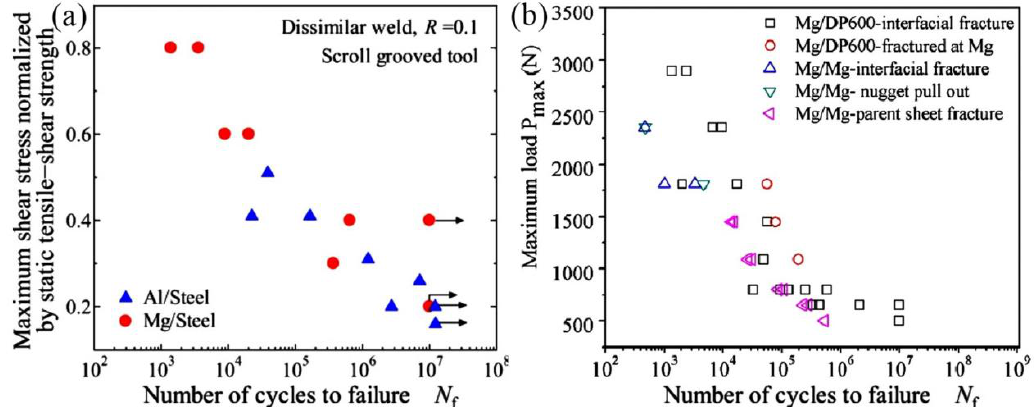
Figure 6. Relationship between maximum load and number of cycles to failure ( a ) Mg alloy/steel friction stir spot welds [26]; ( b ) Mg/steel dissimilar refill friction stir spot welds [14].